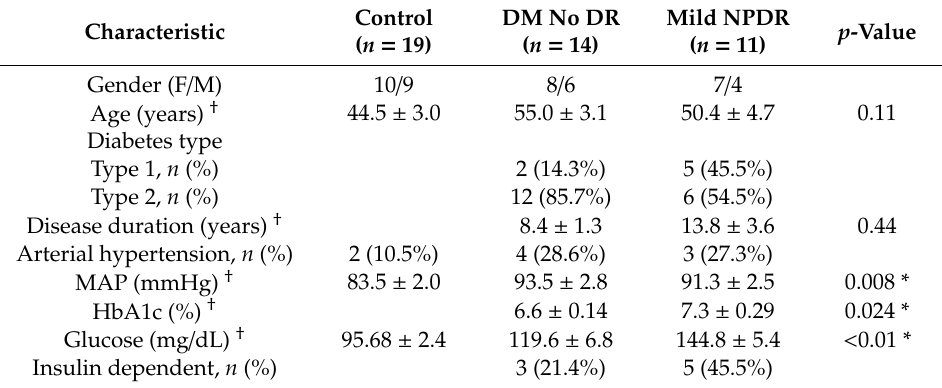
Table 1. Demographic